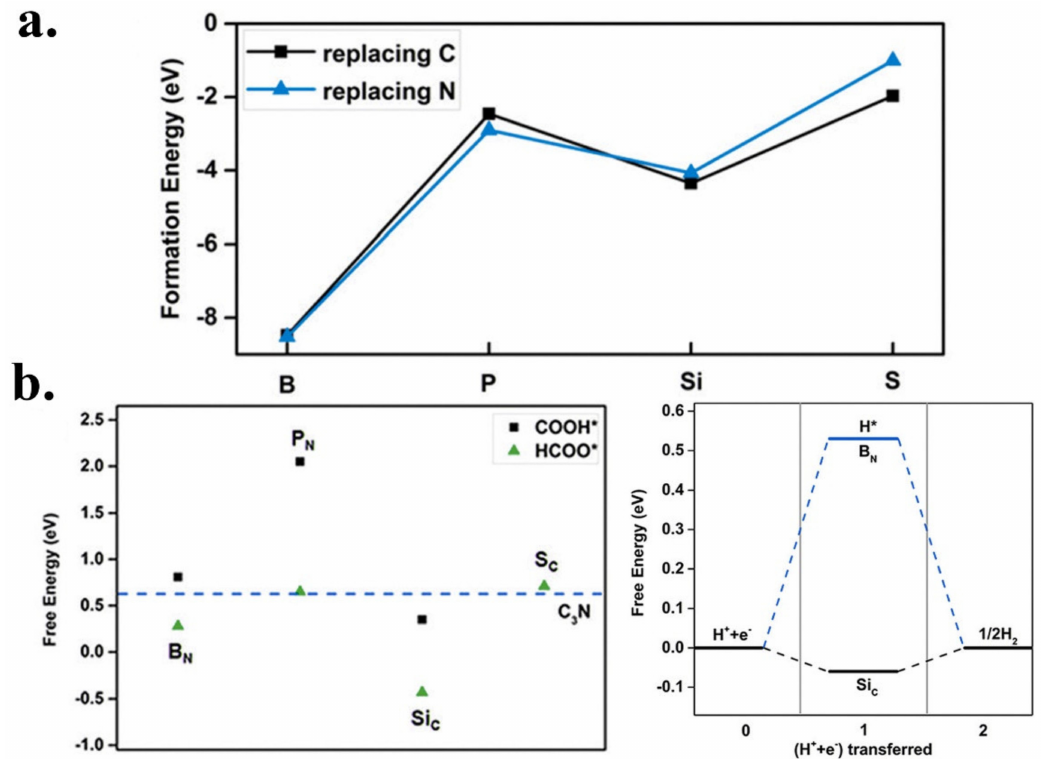
Figure 12. ( a ) Relationship between the formation energy of heteroatom-doped C 3 N replacing N or C and type of doped atom, ( b ) free energies of COOH* and HCOO* adsorbed on heteroatom-doped C 3 N (left) and Energy diagram of HER on B N and Si C -doped C 3 N (right). Adapted from